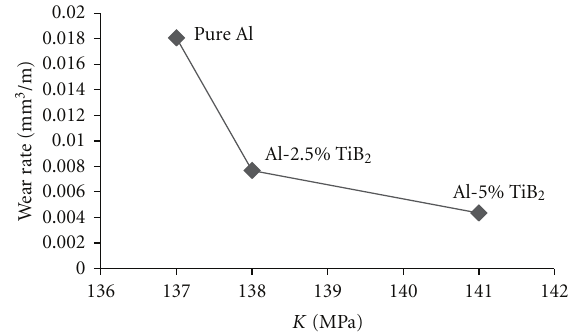
Figure 15: E ff ect of strengthening coe ffi cient on wear rate of composites.